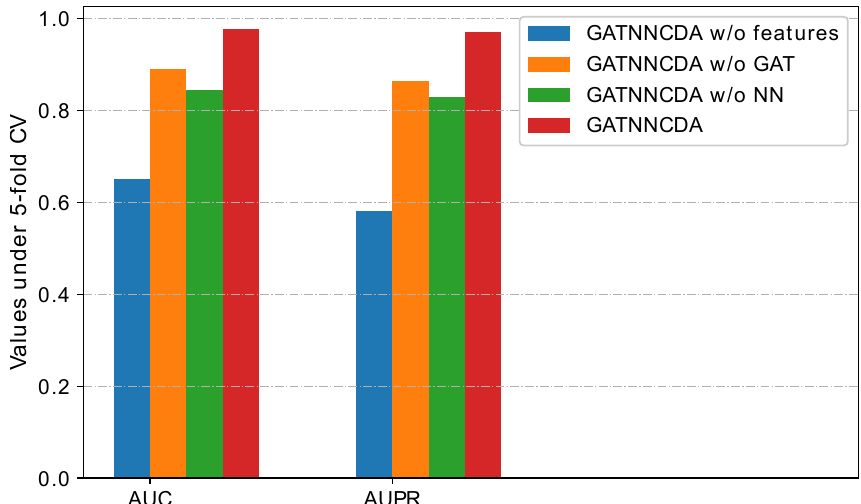
Figure 3. The comparison results of GATNNCDA and its variants based on CircR2Disease dataset.